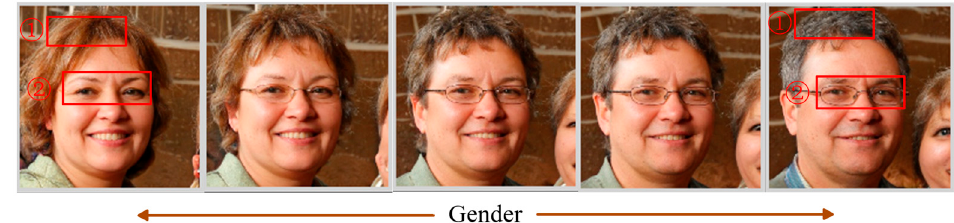
Figure 2. Entanglement of gender attributes with other semantic attributes in